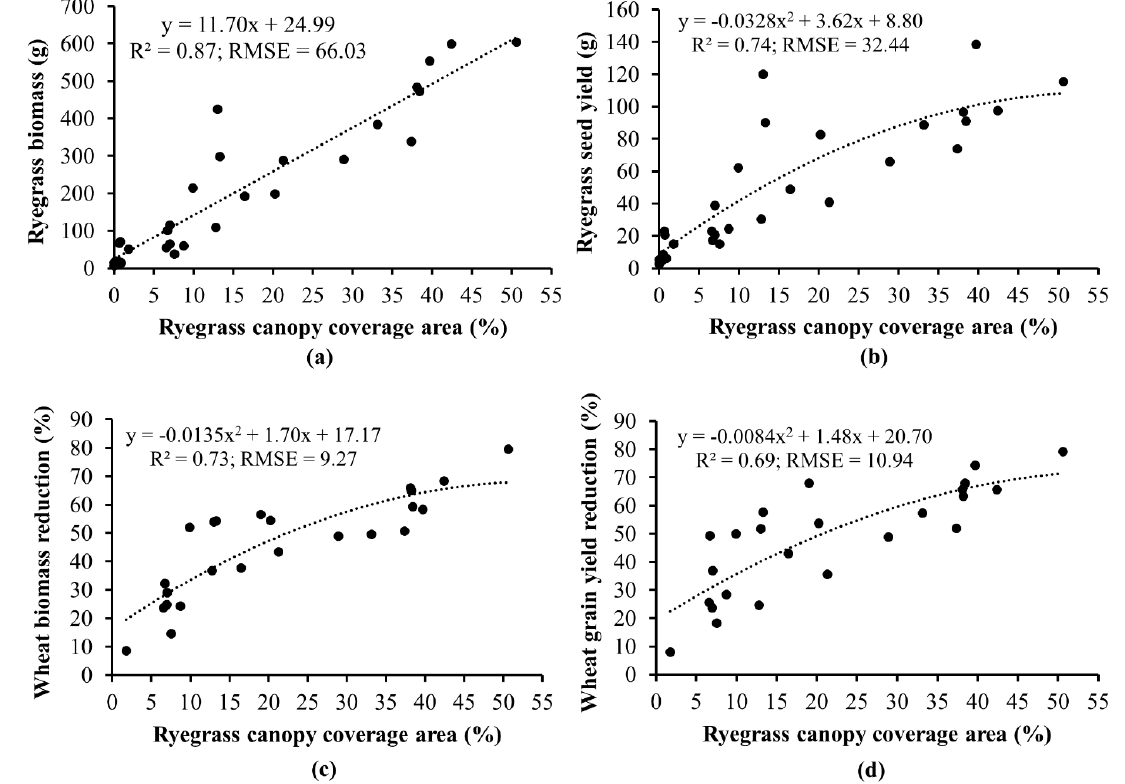
Figure 7. Regression analysis between Italian ryegrass canopy coverage area (%) determined using image analysis and ground truth Italian ryegrass biomass ( a ), Italian ryegrass seed yield ( b ), wheat biomass reduction (%) ( c ), and wheat grain yield reduction (%) ( d ). The canopy coverage area (%) was derived from the classified images for experimental units (1 m × 1 m), whereas predicted variables (y-variables) were ground / field-based data.